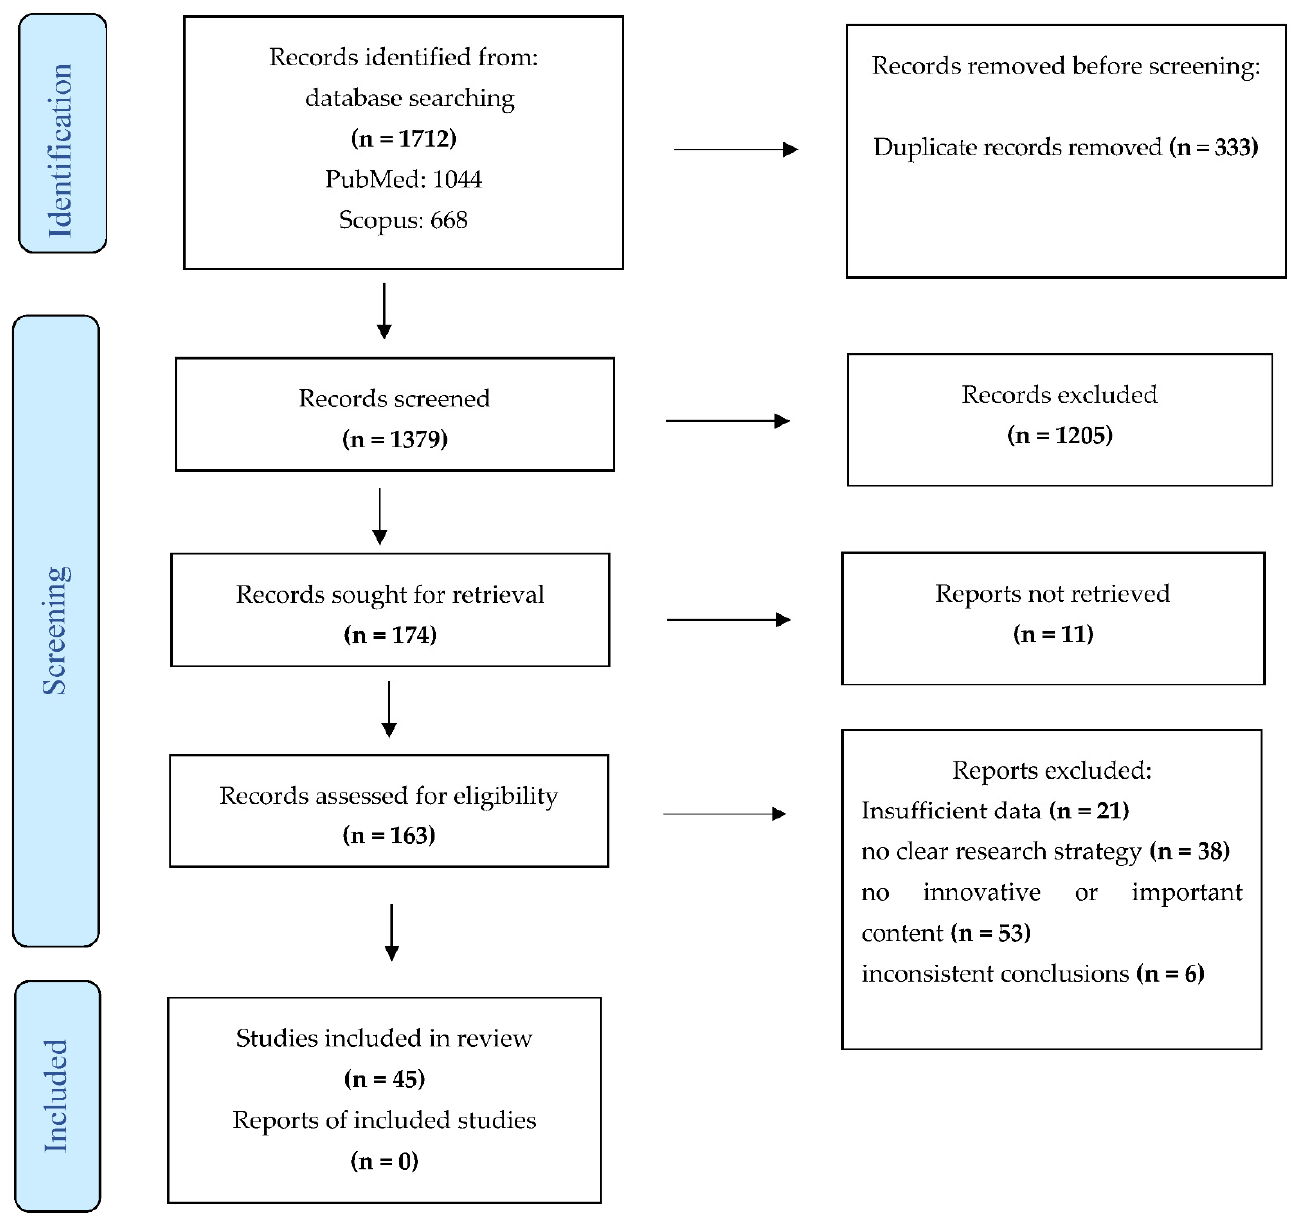
Figure 1. PRISMA flow diagram.